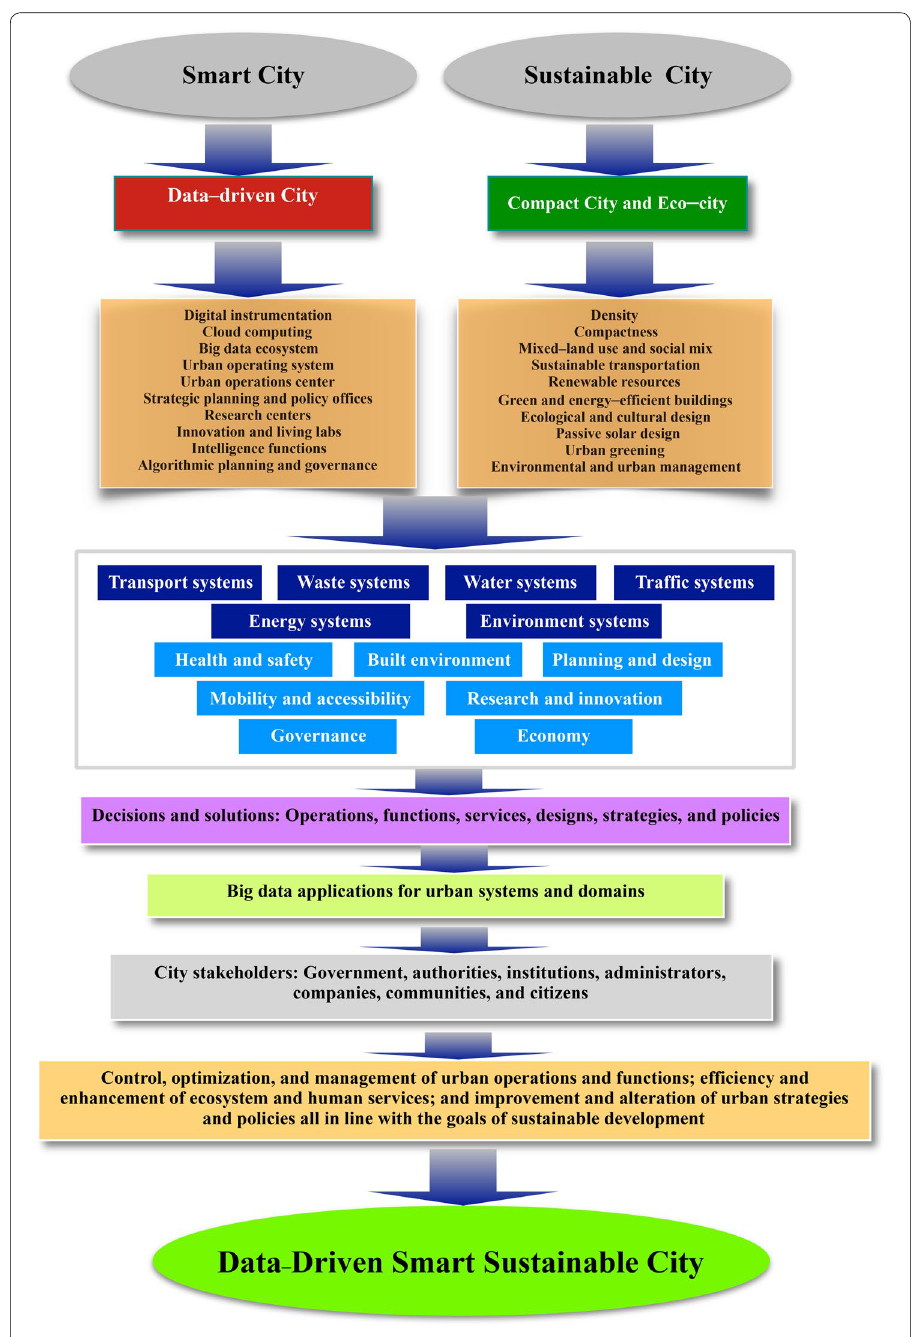
Fig. 2 An architecture of the data-driven smart sustainable